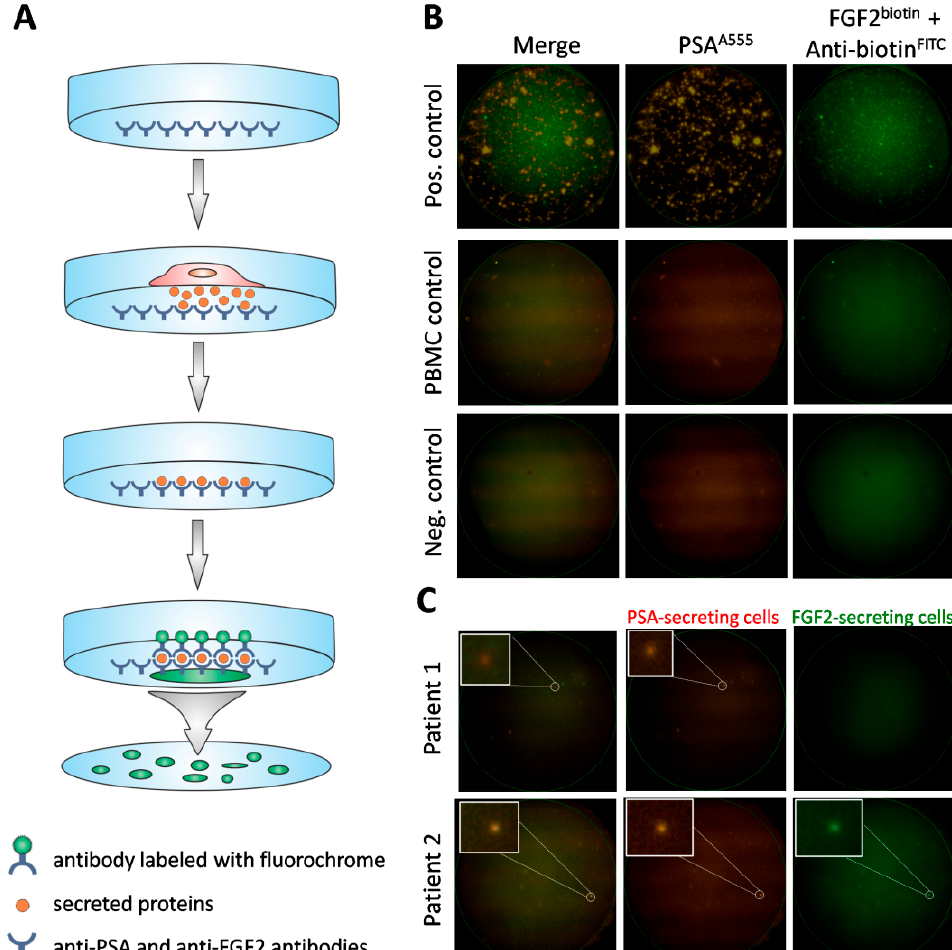
Figure 2. Detection of viable CTCs using the dual fluorescent EPISPOT PSA / FGF2 assay. ( A ) Procedure of the assay. Membrane covered with anti-PSA and anti-FGF2 antibodies, culture of cells enriched via depletion of CD45 + cells, binding of secreted proteins to previously immobilized antibodies, immunostaining of secreted proteins caught on the membrane. ( B ) Positive and negative controls. Culture of LNCaP (shown in figure) and NBTII cells (secreting PSA and FGF2, respectively) as positive controls, culture of PBMC (not secreting PSA nor FGF2) and wells without cells used as negative controls. A single immunospot corresponds to the protein “fingerprint” of one viable cell. ( C ) Patient samples. Representative examples of CTCs defined based on PSA-secretion (Patient 1) or PSA and additionally, FGF2 (Patient 2). PSA-positive, FGF2-positive and double PSA / FGF2 immunospots (merge) correspond to viable CTCs. Immunospots were detected and observed using the C.T.L. Elispot Reader, 50 × magnification.